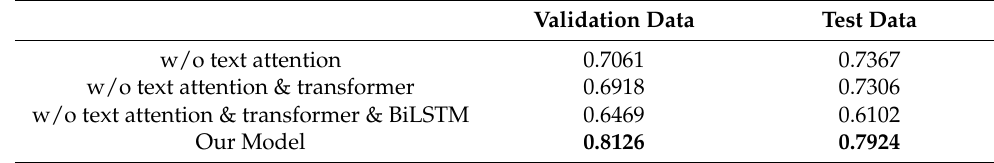
Table 3. Accuracy in component ablation